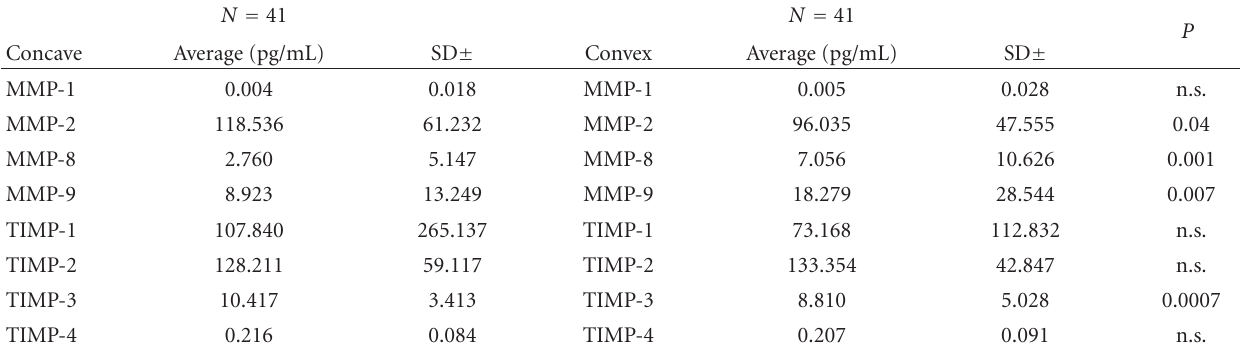
Table 2: Overall detection of MMPs and TIMPs using the multiplex